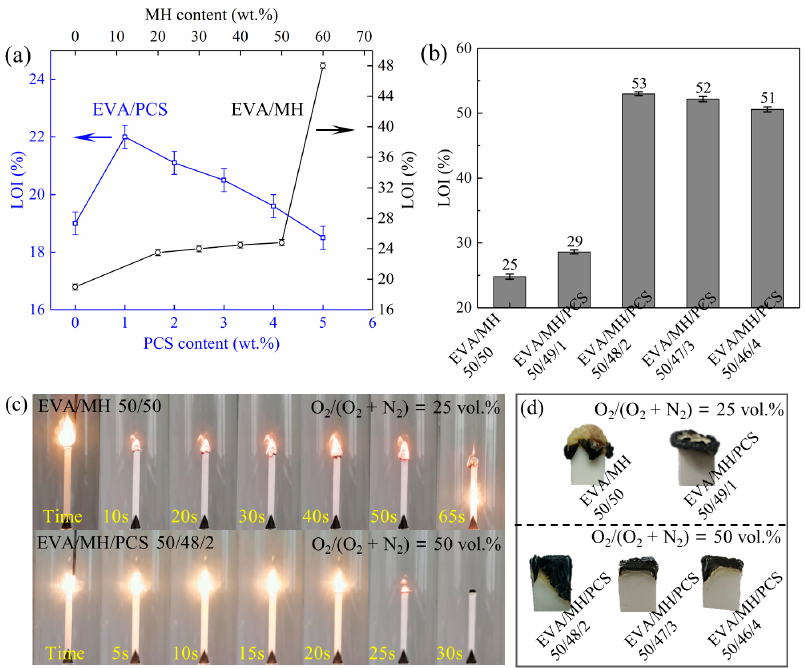
Figure 2. The LOI test results: ( a ) the LOI values of EVA with different PCS and MH content; ( b ) the LOI values of the EVA/MH with different PCS content; ( c ) the burning state during testing of EVA/MH 50/50 and EVA/MH/PCS 50/49/1,and ( d ) the pictures of the extinguished residues after testing.